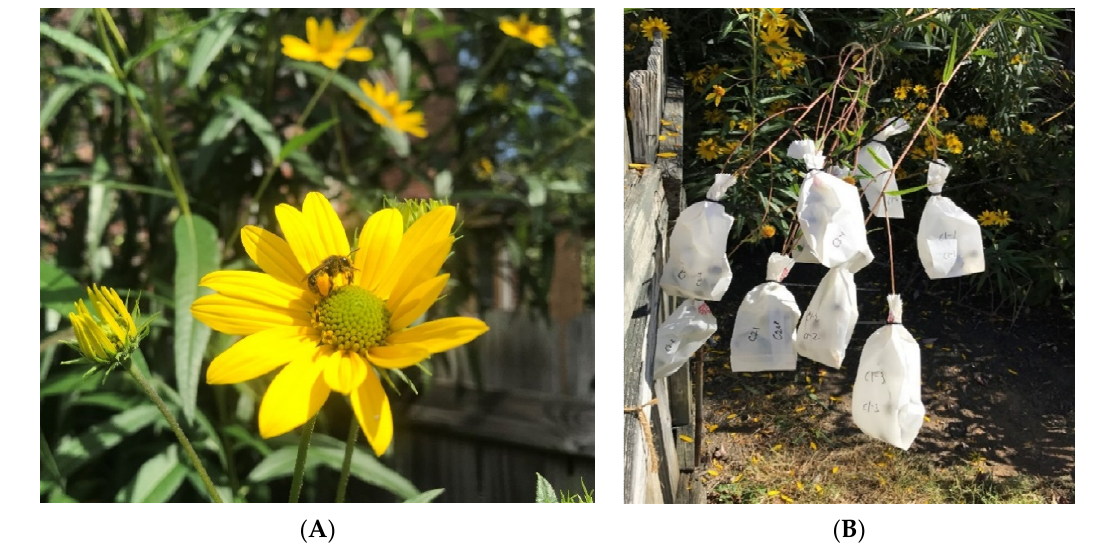
Figure 3. Floral visitor and seed collection for Helianthus verticillatus . ( A ). A native bee ( Melissodes species; longhorn bee) visitor to an inflorescence of H. verticillatus in early-October, 2018. Note yellow pollen on the leg of the bee. ( B ). Pollination bags covering multiple inflorescences after floral discs turned brown-black in mid-to-late October, 2018.